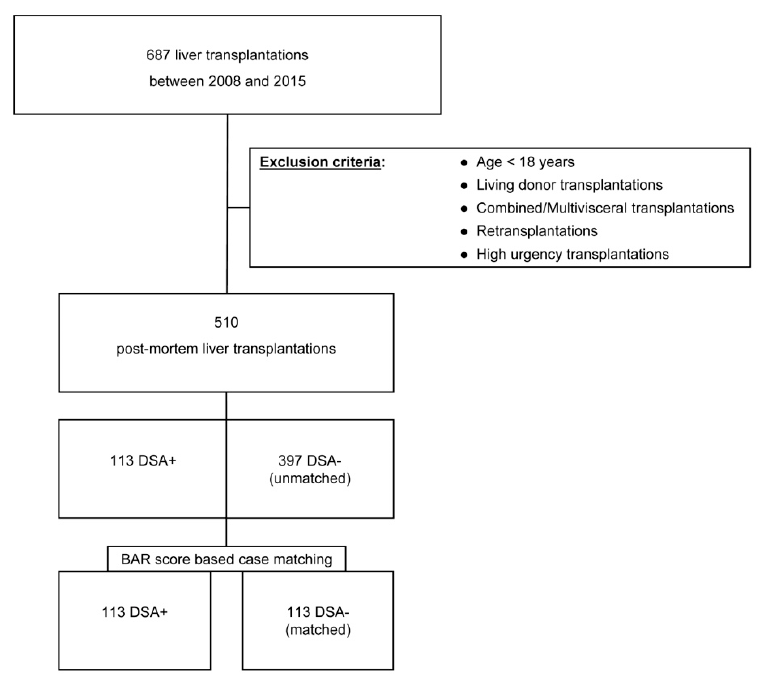
Figure 1. Visualization of the patient selection and matching process.